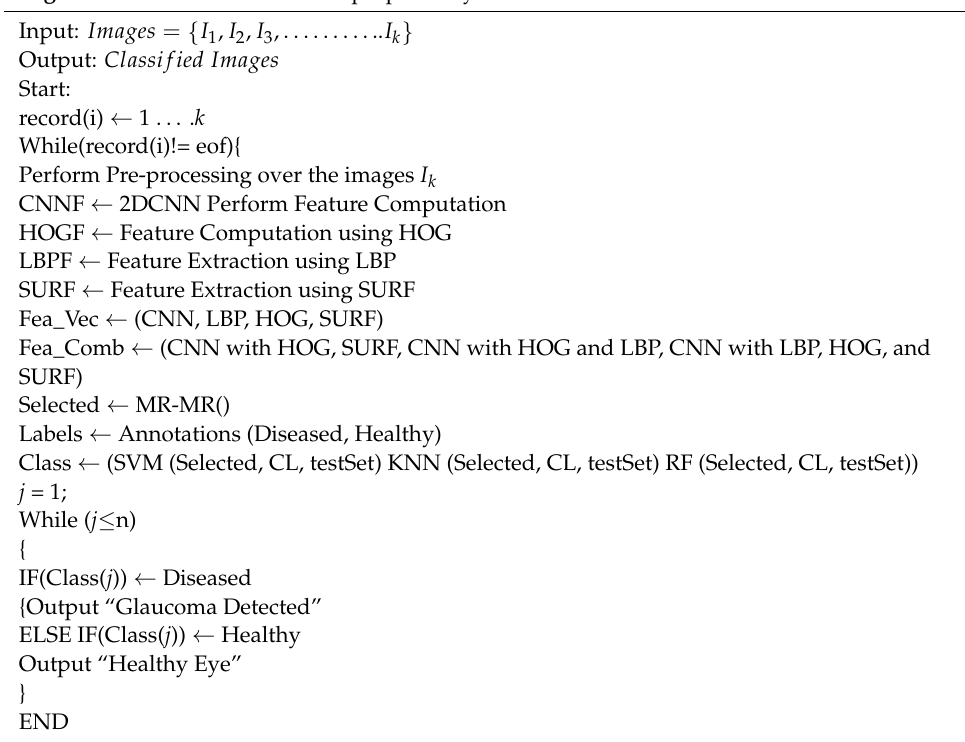
Figure 4. Architecture for the proposed model. Algorithm 1: Pseudocode for the proposed